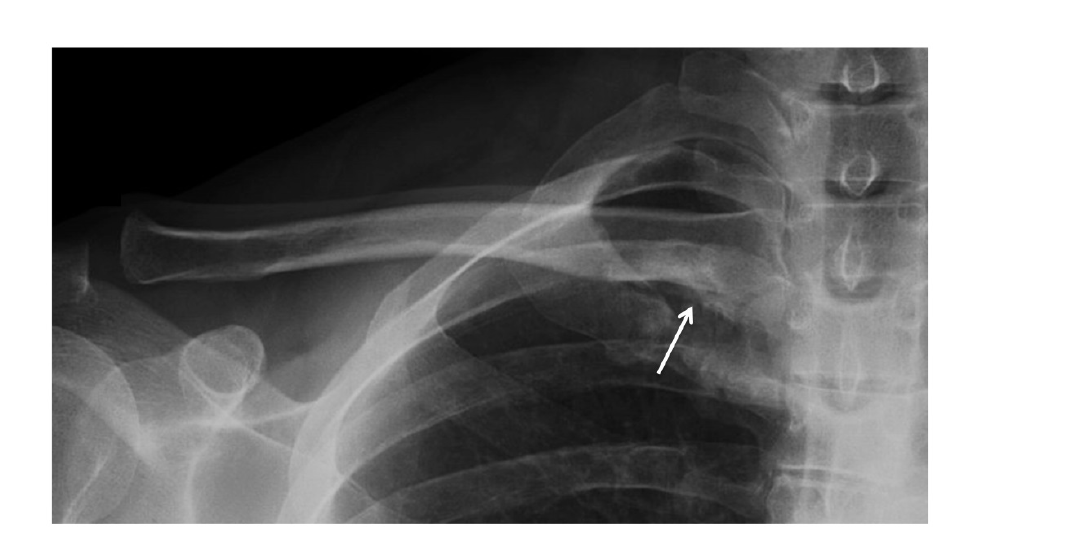
Figure 8. AP study reveals subtle medial clavicular sclerosis and inferior cortical erosion